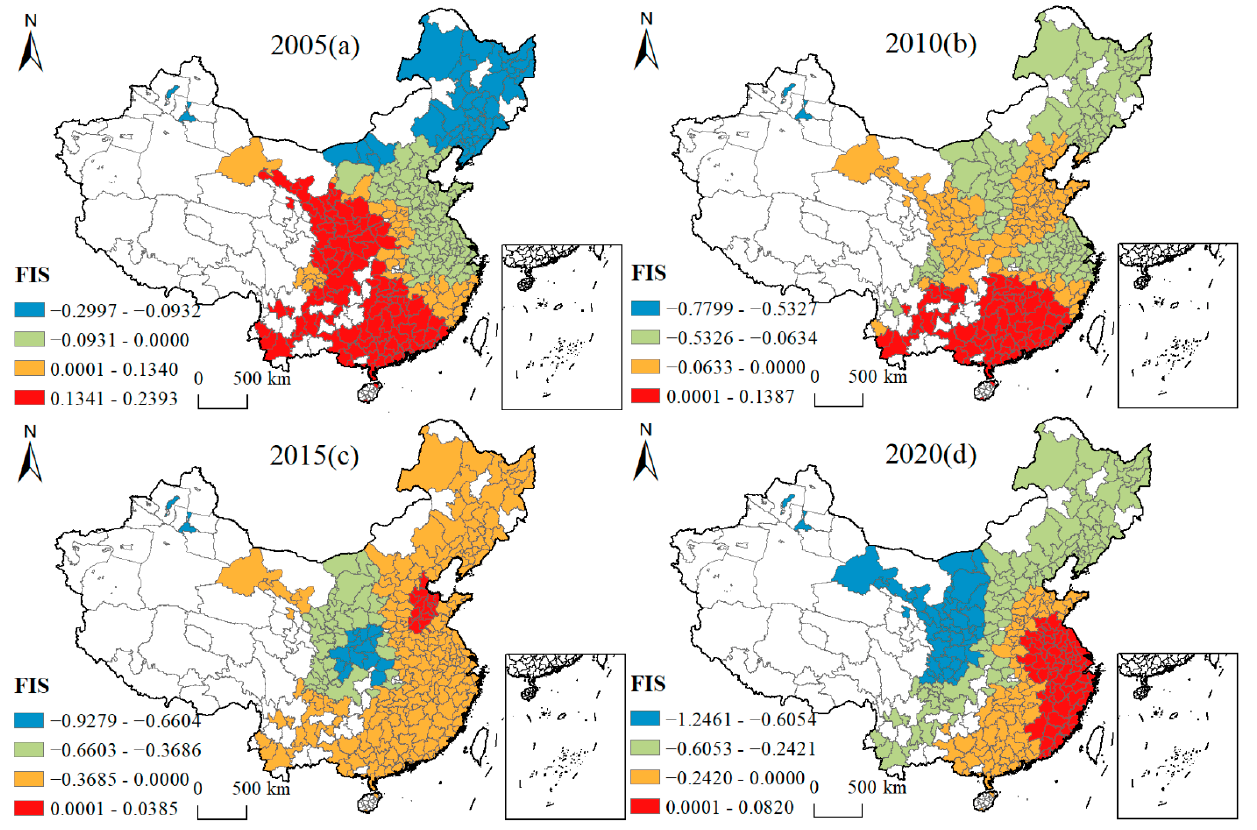
Figure 9. Four-year regression coefficients of FIS.